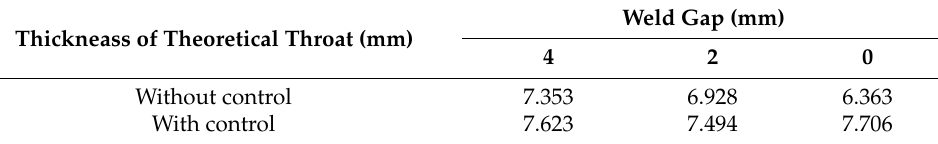
Table 11. Comparison thickness of theoretical throat with and without control (Optimal conditions for 4 mm